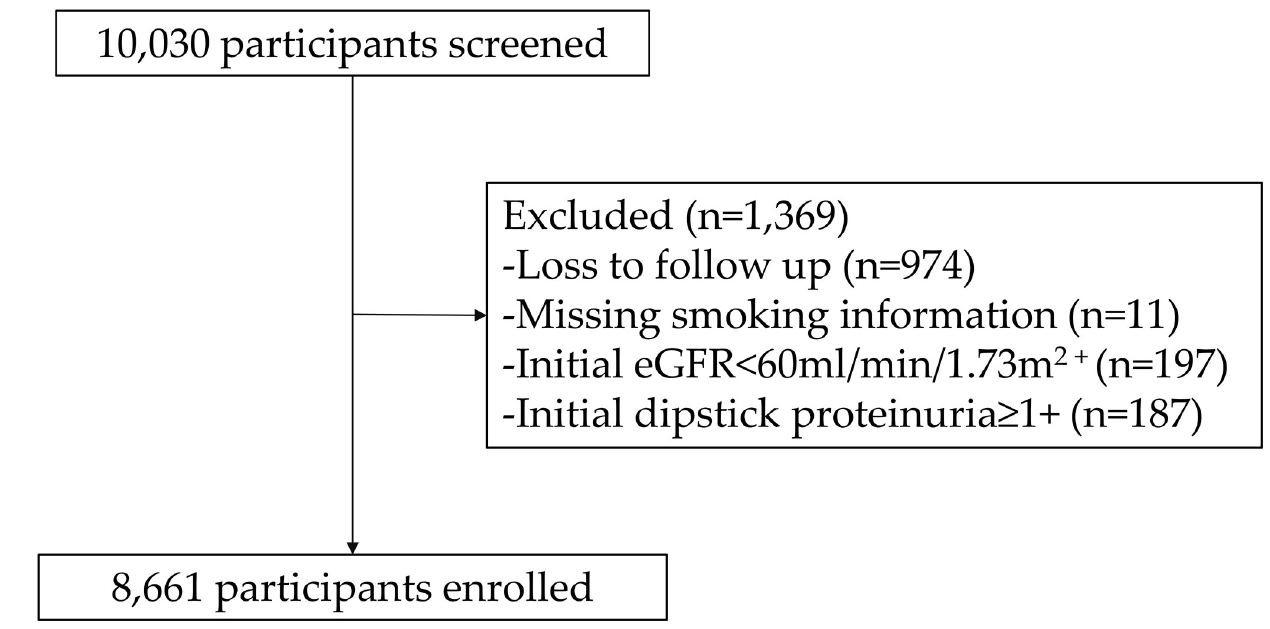
Fig 1. Flow diagram of the study cohort. Abbreviation : eGFR, estimated glomerular filtration rate.